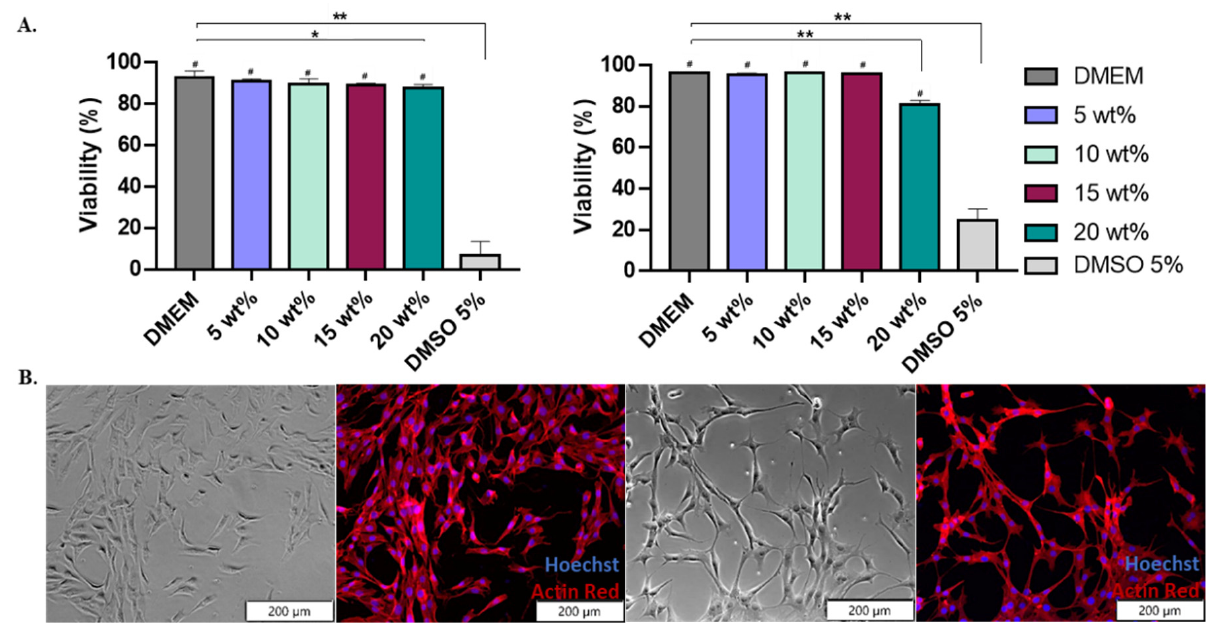
Figure 4. Terpolymer cell viability using NIH-3T3 cell line. ( A ) The general trend of 2:4:94 P400 ( left ) and 10:4:86 P1000 ( right ) cell viability (%) test of NIH-3T3 cell line for an exposure time of 24 h with concentrations of 5, 10, 15, and 20 wt.% of terpolymer in cell culture media for n = 12. p -values: 0.0383 (* versus DMEM), <0.0001 (** versus DMEM) and <0.0001 (# versus DMSO). ( B ) Brightfield and fluorescent images of NIH-3T3 cell line cultured on tissue culture plate ( left pictures) and 2:4:94 P400 terpolymer at 15 wt.% ( right pictures). Pictures show cells live at 24 h of incubation. The fluorescent image shows the stained cytoskeleton with Actin Red (red color) and the cell nucleus with Hoechst (blue color).